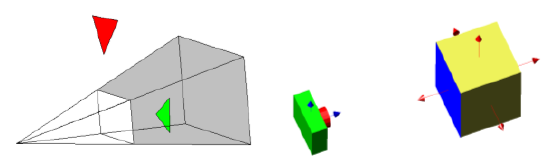
Fig. 10. View frustum and back-facing culling principles (only the blue part of the box must be